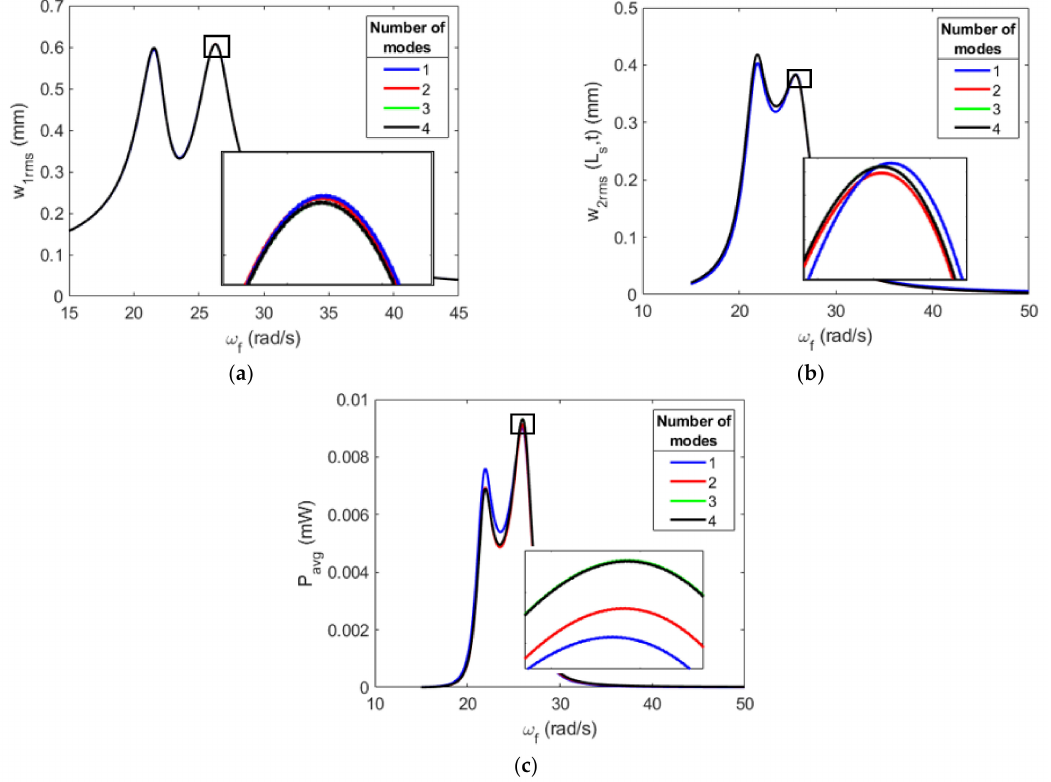
Figure 7. Convergence analysis of the repulsive–repulsive configuration for the ( a ) displacement of the primary structure, ( b ) absorber’s displacement and ( c ) power